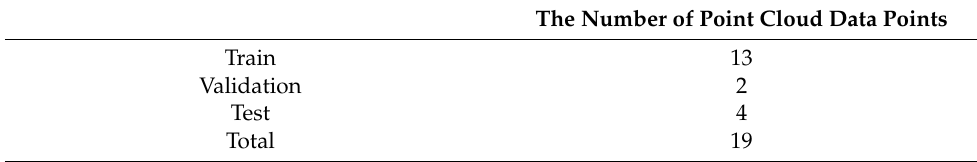
Table 4. Point numbers of point